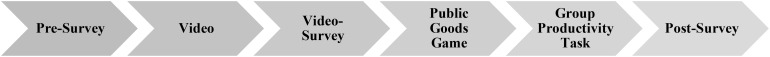
The time course of the experiment.